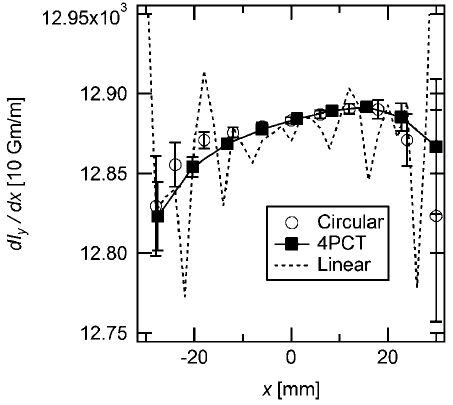
FIG. 14. Gradient computed from multipoles and measured